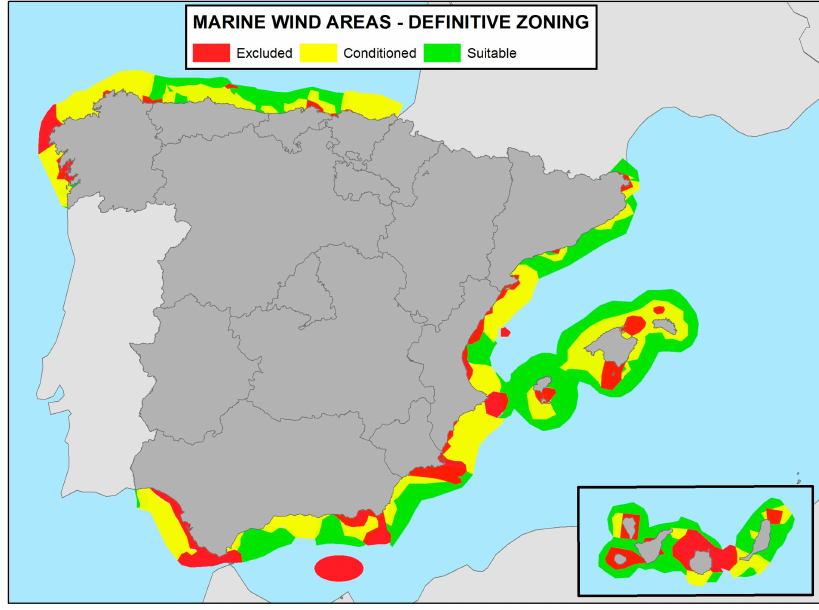
Figure 13. Areas for wind farms location on the Spanish coast, based on